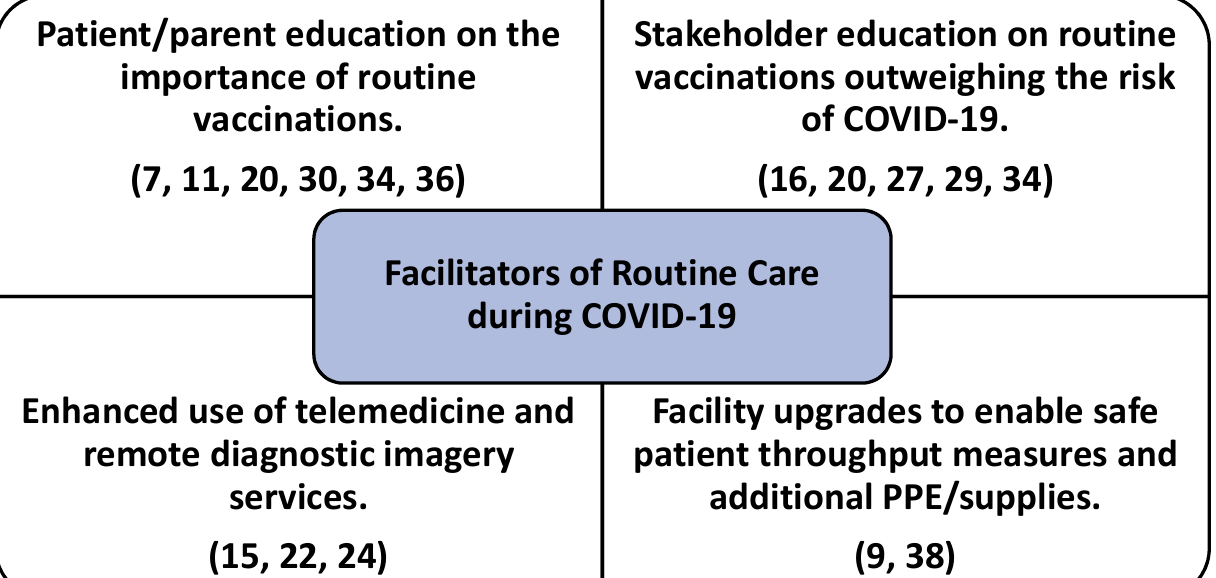
Figure 2. Underlying variables (constructs) identified as facilitators for the delivery of routine care during the pandemic.